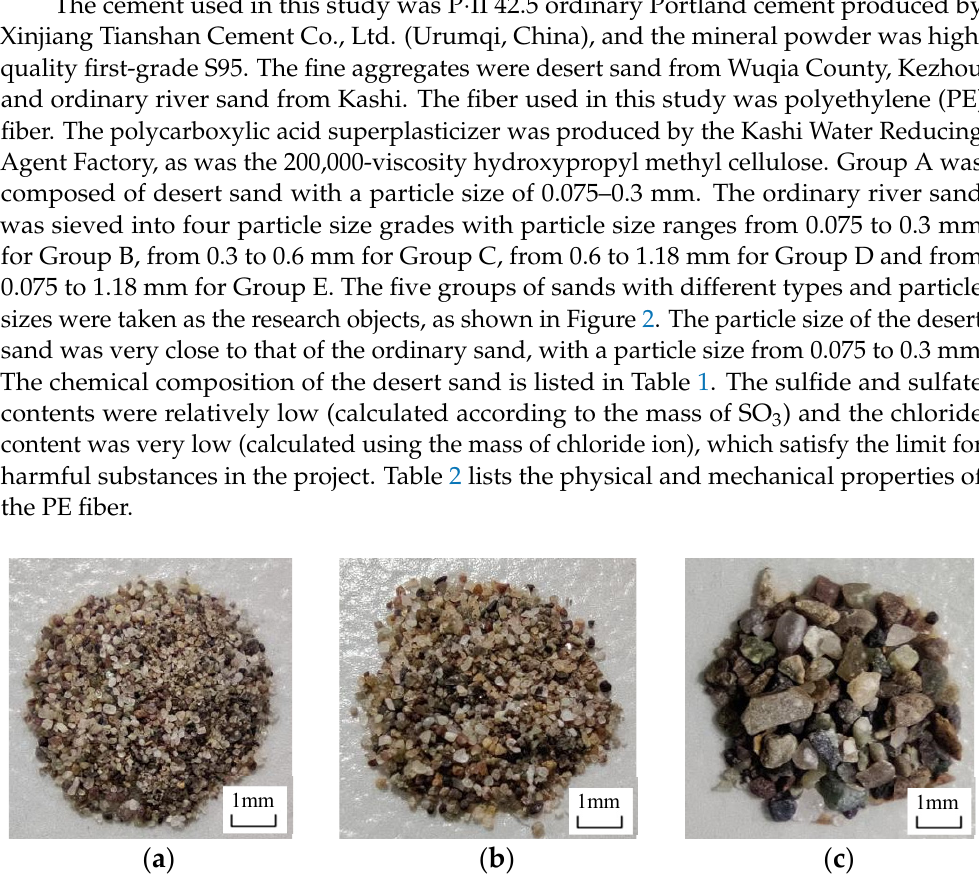
Figure 1. Schematic flow diagram of this study.